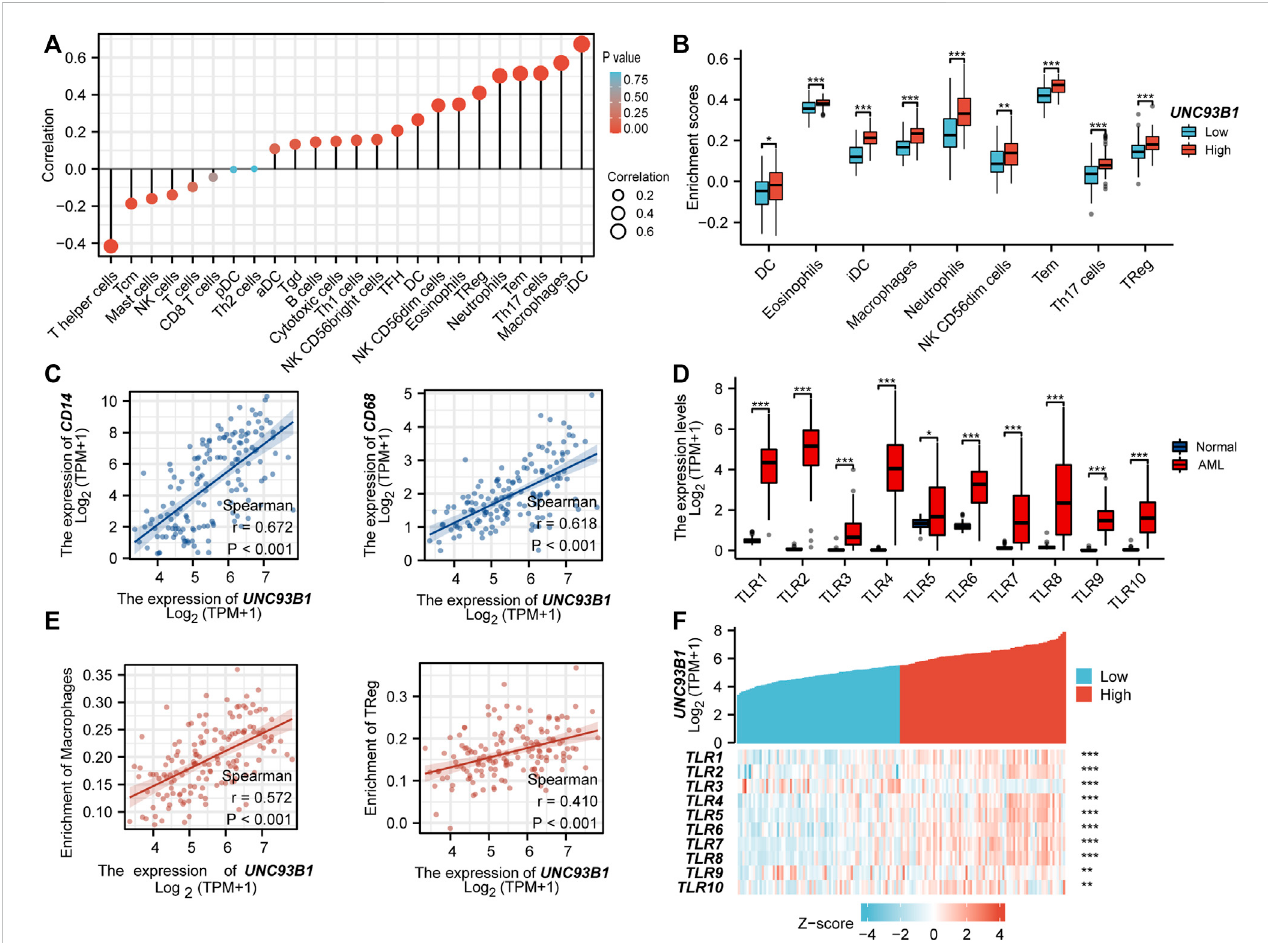
FIGURE 5 UNC93B1 gene expression related to innate immune cell in fi ltration and innate-immune related molecules. (A) Correlation of UNC93B1 expression and 24 kinds of in fi ltrated immune cells. (B) High UNC93B1 expression enriched more immune cells, especially innate immune cells. (C) Positive correlation of UNC93B1 expression level with CD14 and CD68. (D) High expression of TLR family in AML ( n = 173) compare with normal individuals ( n = 70). (E) Positive correlation of UNC93B1 expression level with macrophages and regulatory T cells (Tregs). (F) Expression correlation between UNC93B1 and Toll-like receptors (TLRs) genes in AML. (r means Spearman ’ s correlation coef fi cient. * p < 0.05, ** p < 0.01, *** p <